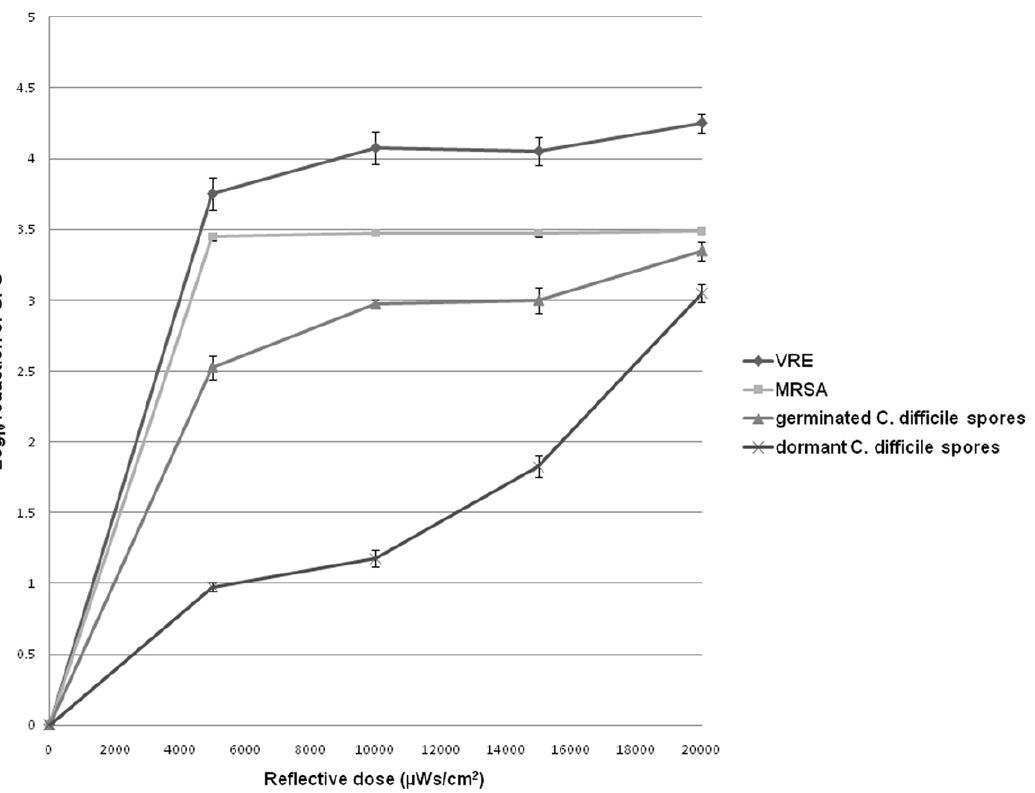
Figure 1. Optimal doses of ultraviolet-C radiation for killing germinating versus dormant Clostridiumdifficile spores, MRSA, and VRE. Mean reduction (log 10 colony-forming units) in recovery of C. difficile spores from an epidemic NAP1/BI strain, a PFGE type USA 300 strain of methicillin-resistant Staphylococcus aureus (MRSA), and a vanB-type strain of vancomycin-resistant Enterococcus (VRE) from laboratory bench top surfaces after the use of a UV-C device at reflected doses ranging from 5,000 to 20,000 m Ws/cm 2 . C. difficile spores were incubated in either water or germination solution for 5 minutes before exposure to UV-C radiation. Spores were confirmed as dormant or germinated by phase contrast microscopy.